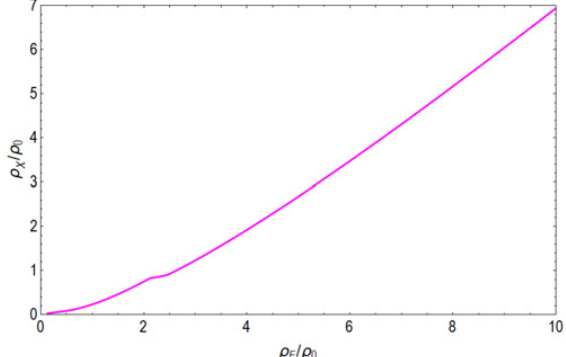
Figure 2. The number of dark matter fermions vs. the total number of fermions (neutrons plus dark fermions) at chemical equilibrium for the QHC18 nuclear equation of state. At twice nuclear matter density, 2 ρ 0 , the ratio is about 0.5 and grows to 0.7 at 10 ρ 0 . The flat region around 2 ρ 0 corresponds to pion